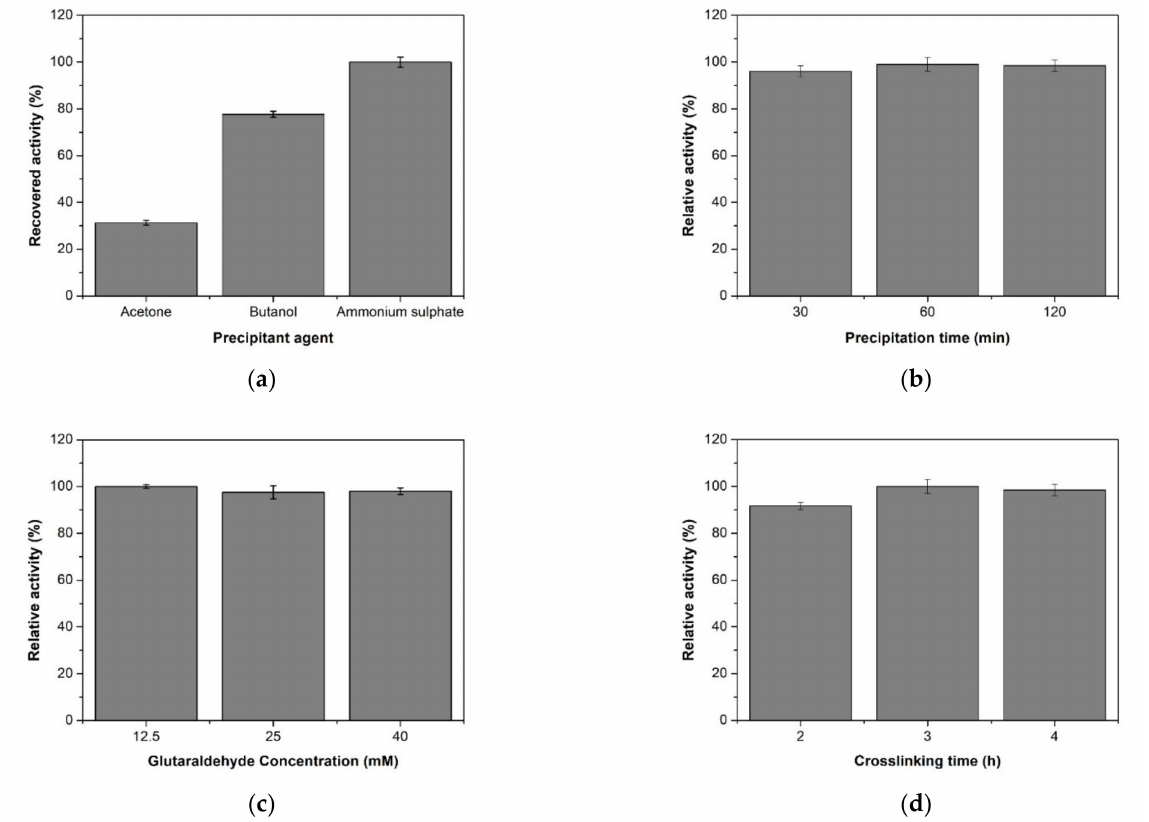
Figure 1. ( a ) Precipitation of XynB2 Y509E with different precipitant agents. ( b ) Precipitation of XynB2 Y509E at different times using 90% of ammonium sulfate. ( c ) Concentration of glutaraldehyde for cross-linking reaction. ( d ) Time of cross-linking using 12.5 mM of glutaraldehyde. All values are the mean of three replicates and error bars represent standard